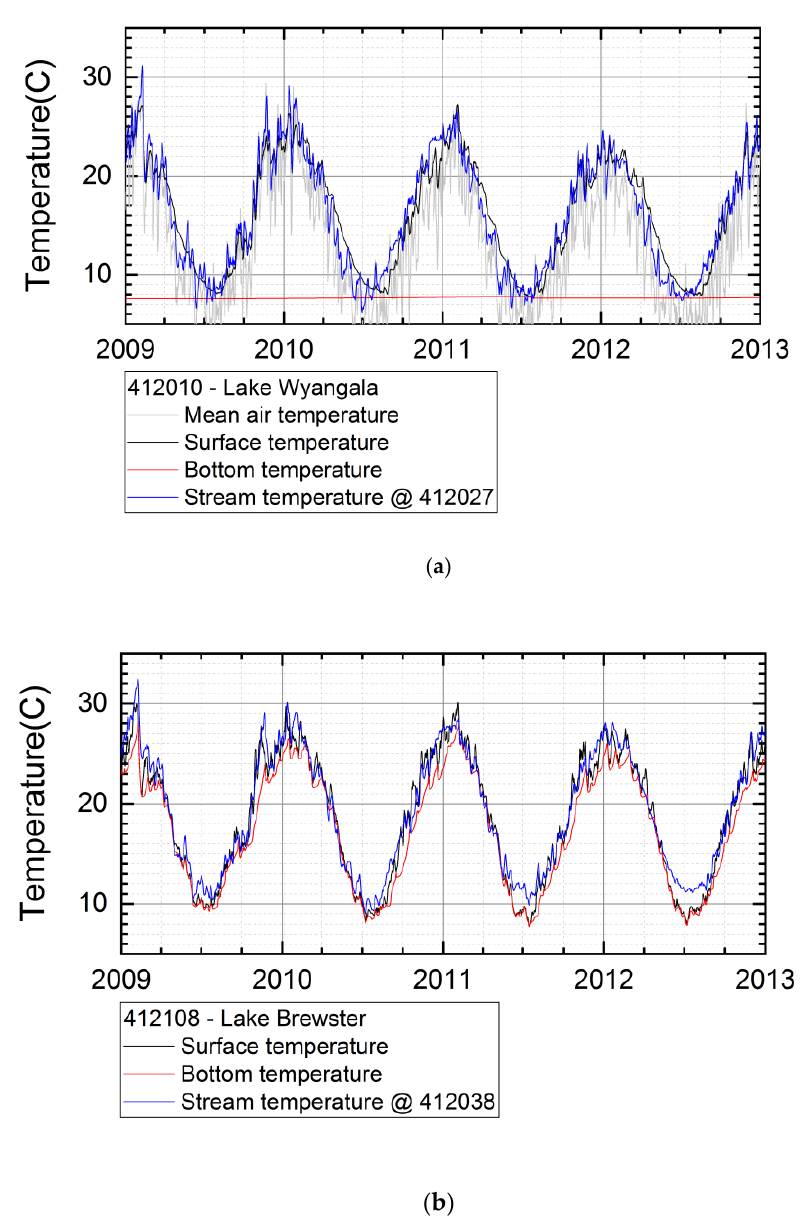
Figure 3. ( a ) Deep Lake Wyangala showing strong stratification (low bottom as compared with surface temperature); ( b ) Shallow Lake Brewster showing week stratification and frequent mixing (similar surface (black) and bottom (red) temperatures) with similar results for lake and stream model (blue). The grey line shows air temperature.